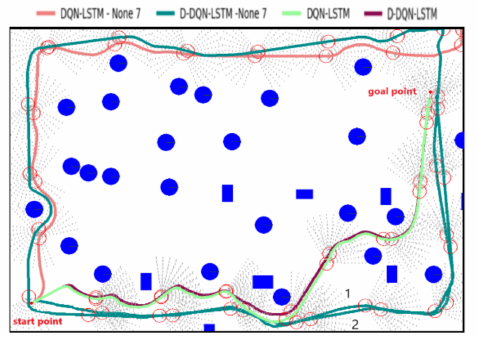
Figure 6. Comparison of DQN-LSTM and D-DQN-LSTM with or None policy 7.